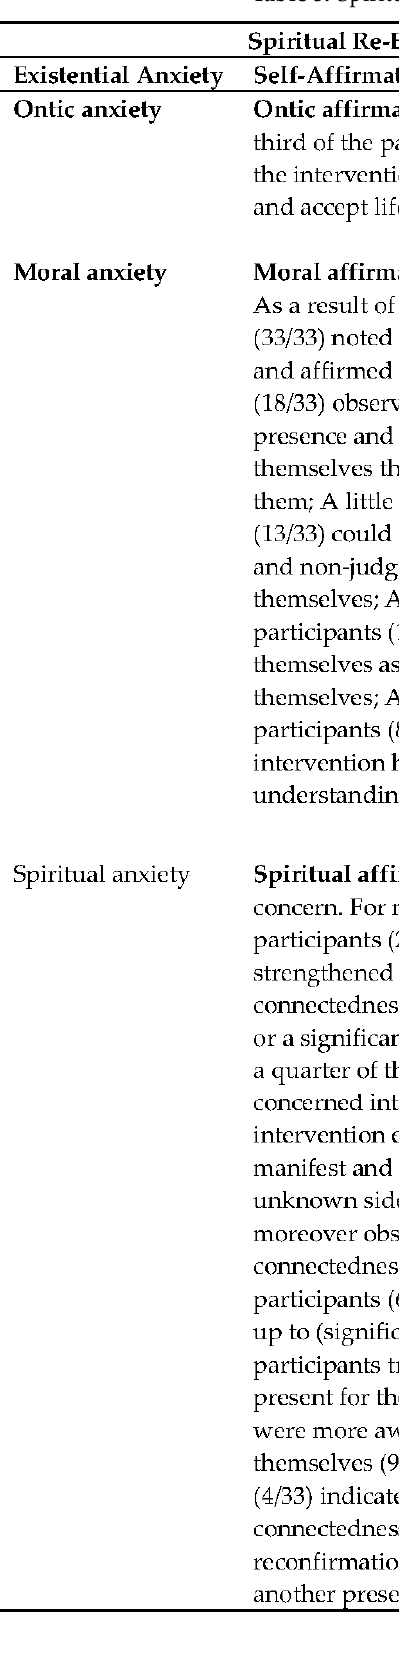
Table 5. Spiritual re-evaluation after the intervention.